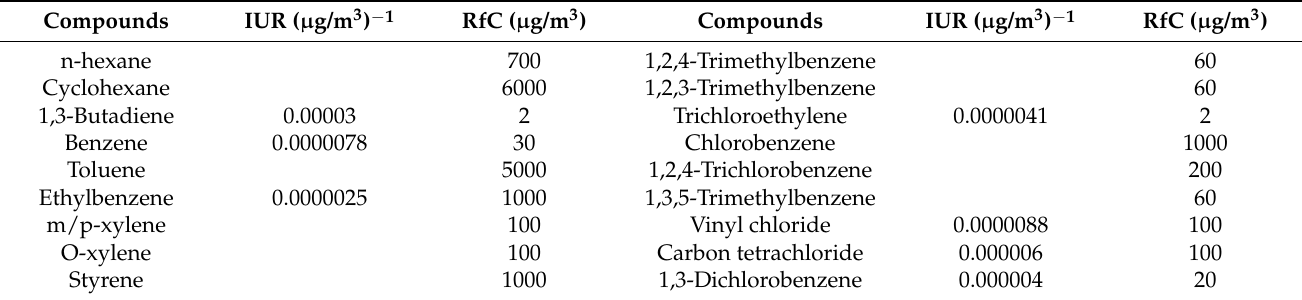
Table 6. VOCs risk assessment related parameters.